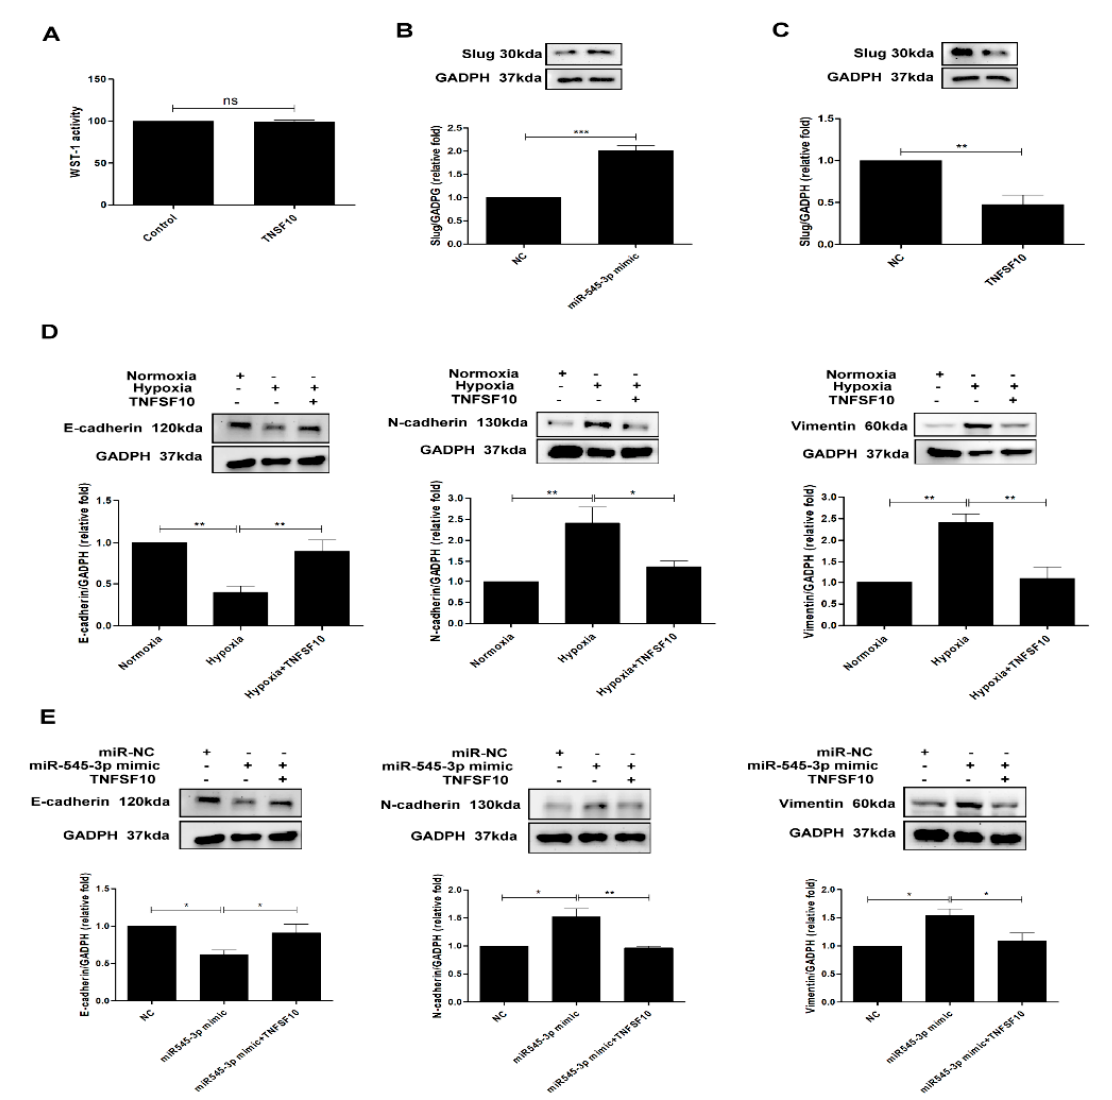
Figure 4. Hypoxia induces EMT in HK-cells by miR-545-3p–TNFSF10 modulation. ( A ) Cell viability activity was examined in HK-2 cells treated with normal control or TNFSF10 (20 ng/mL) for 48 h using the WST-1 assay. ( B ) Slug protein was assessed in HK-2 cells after transfection with the miR-NC (200 nM) or miR-545-3p mimic (200 nM) for 24 h and then cultured under normoxia conditions for 48 h. ( C ) Slug protein was also examined in HK-2 cells treatment with TNFSF10 (20 ng/mL) under normoxia for 48 h. ( D ) EMT markers were examined in HK-2 cells treated with normoxia, hypoxia, and TNFSF10 (20 ng/mL) plus hypoxia for 48 h. ( E ) HK-2 cells were transfected with the miR-NC (200 nM) or miR-545-3p mimic (200 nM), and 24 h after transfection, cells were treated with TNFSF10 (20 ng/mL) for 48 h. EMT was assessed by Western blotting for E-cadherin, N-cadherin, and vimentin. The bar graph represents the mean ± SEM of at least three independent experiments. * p < 0.05, ** p < 0.01, *** p < 0.001 by Student’s t